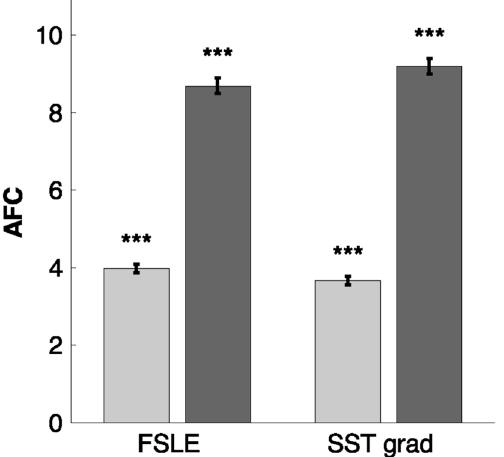
◦ C/km respectively; 18,47 )